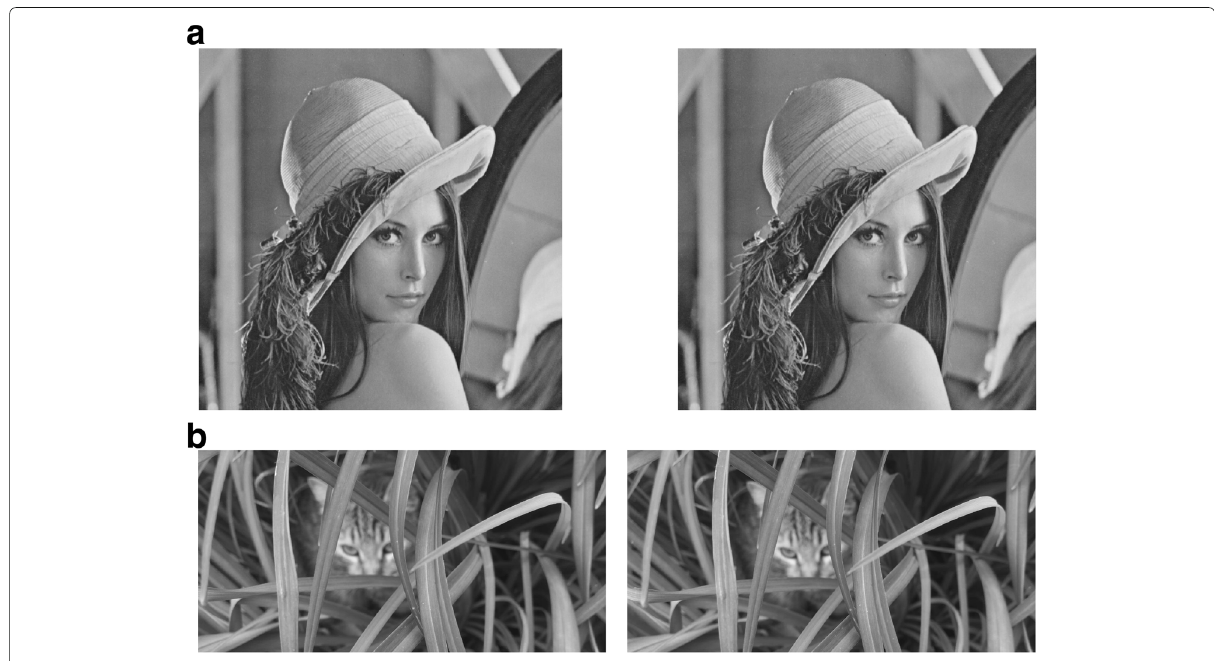
Fig. 1 Embedding 64 bits in the spatial domain. a PSNR = 57.41 dB. b PSNR = 79.16